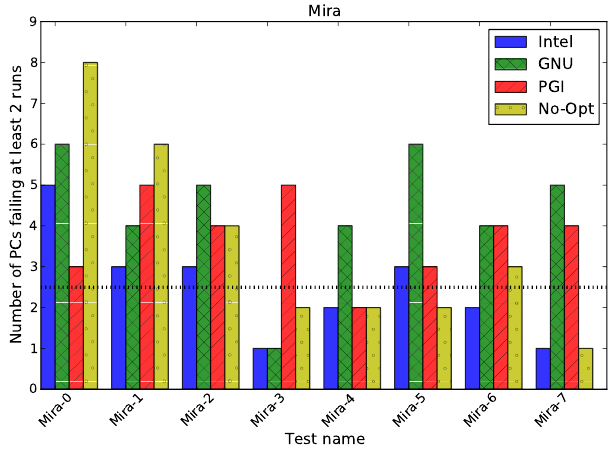
Figure 4. Additional CESM-ECT results on Mira, comparing against four different ensemble distributions. Bars extending above the dashed line indicate an overall